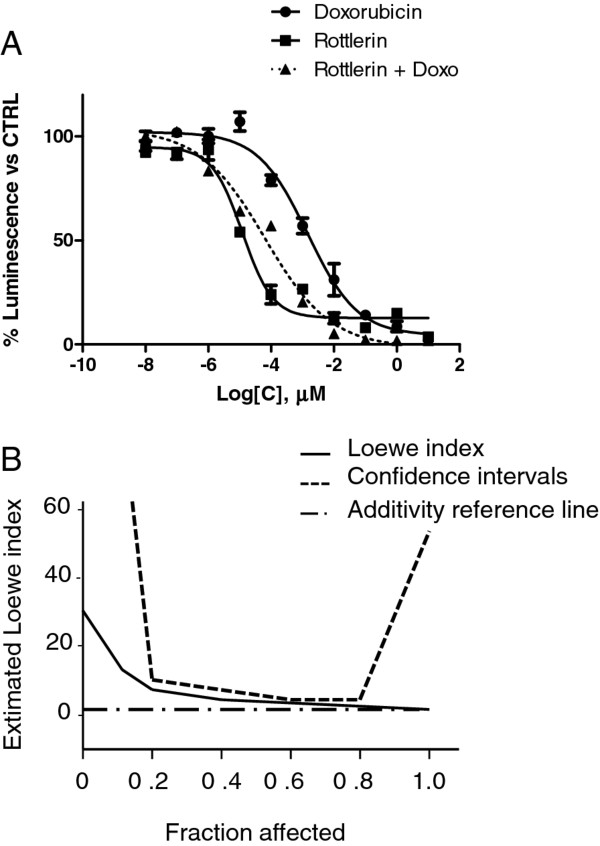
A. Antagonistic effect of doxorubicin on rottlerin. Sigmoidal inhibition curves for MCF-7 cells treated either with doxo or rottlerin, or with the two drugs together in a constant ratio of 1:10. The IC50 were calculated by nonlinear regression, using Graphpad Prism software. As shown by the dashed line, doxo antagonizes the action of rottlerin, producing a shift to the left of its curve. B. Graphic representation of the combination index calculated following the Loewe model. The combination index of the rottlerin-doxorubicin mixture, never goes below the additivity reference line of one, indicating that doxorubicin and rottlerin have antagonistic effects. All the experiments were performed in quadruplicate and repeated at least twice.